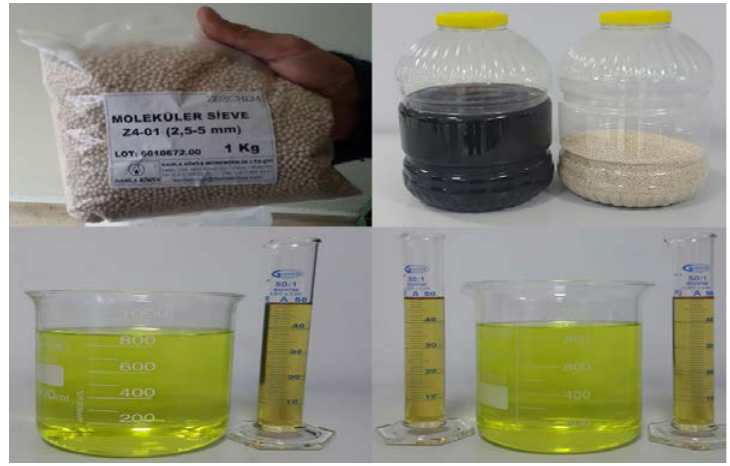
Figure 2. Sieve Z4 -01 (2.5– 5 mm) moisture scavenger and improved fusel –gasoline blends.